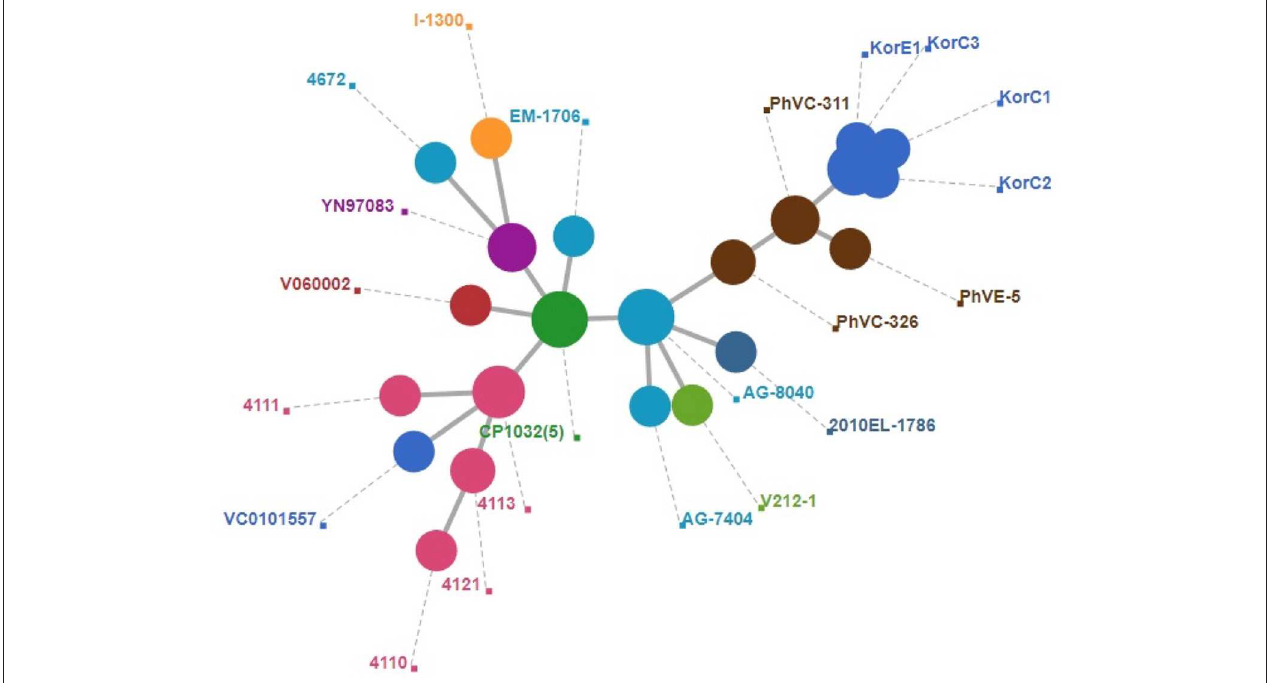
FIGURE 2 | Minimum spanning tree of wgMLST based on 2,340 core genes of V. cholerae . A cluster of blue circle depicts Korean outbreak strains and nearest yellow circles indicate the strains that caused the 2011 Philippines outbreak.